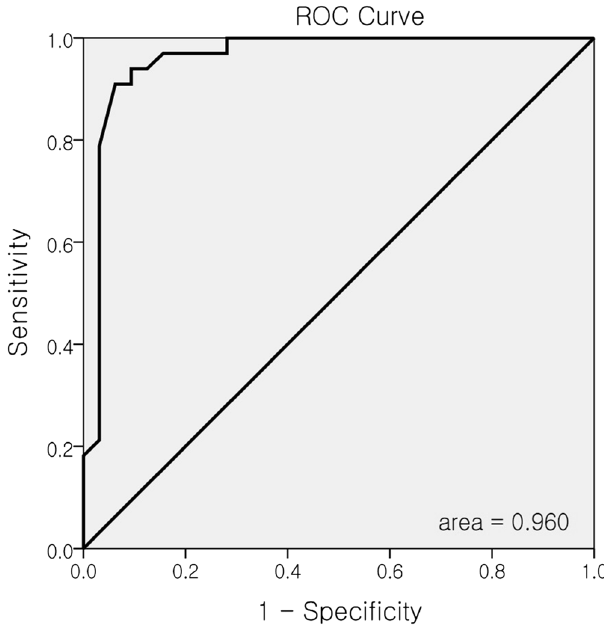
Figure 3. Receiver operating characteristic (ROC) curve analysis resulted in 318 mOsm/L as the threshold to classify dry eye disease. Sensitivity = 90.9%, Specificity =